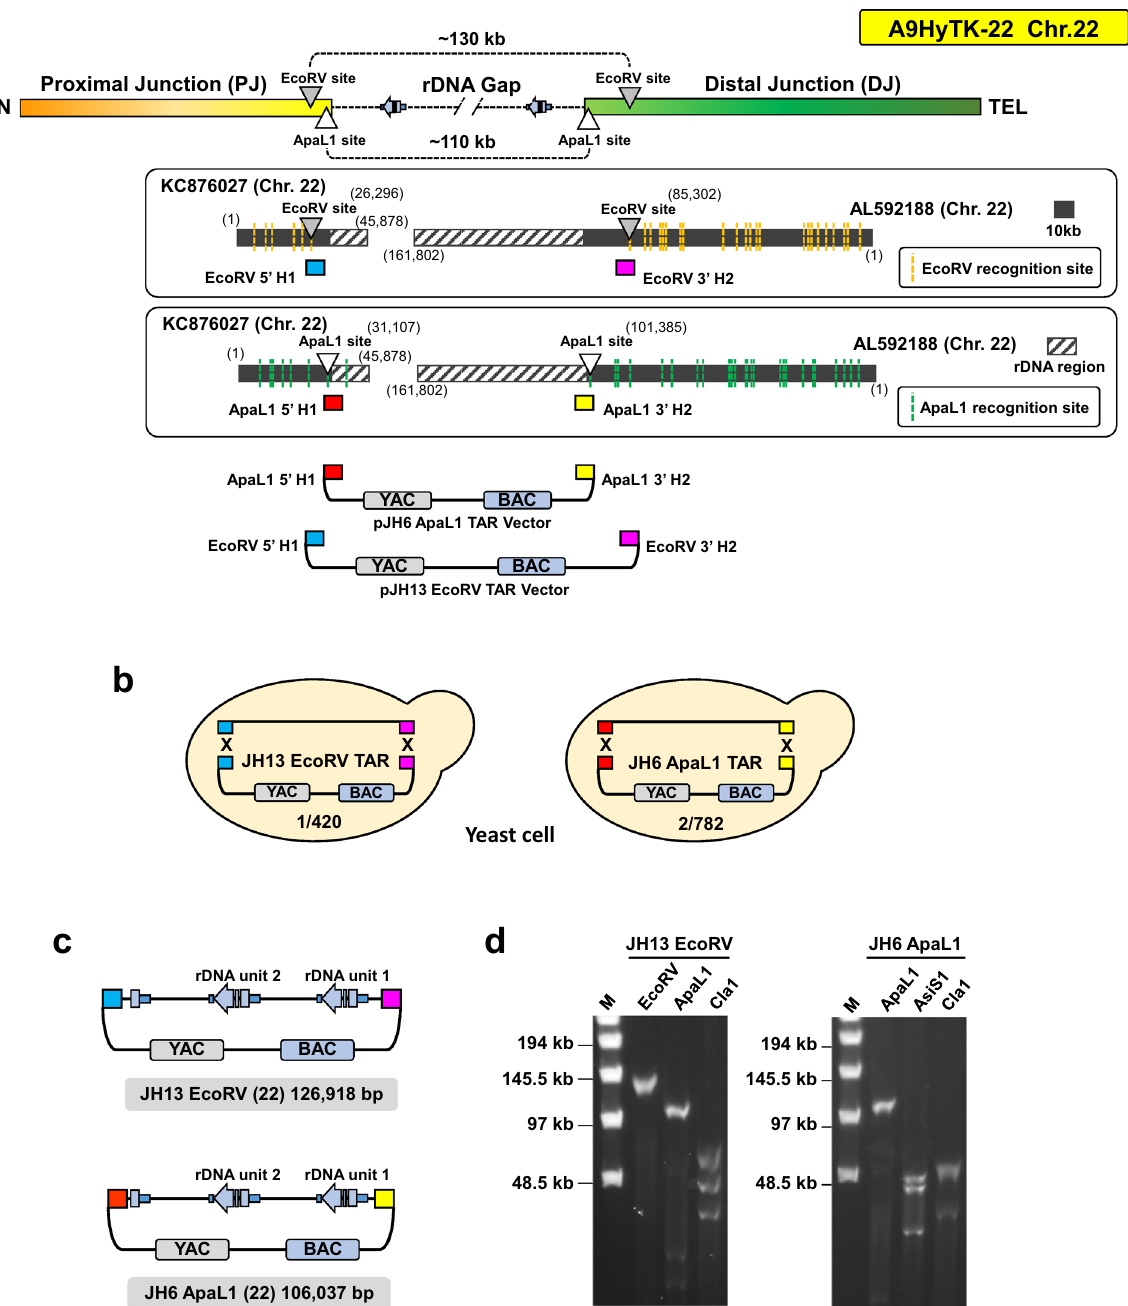
Figure 2. Designing of TAR cloning vector and Closing the rDNA gap on chromosome 22. ( A ) Schematic diagram illustrating the expected innermost EcoRV (gray triangle) or ApaL1 (white triangle) enzyme recognition sites of the human chromosome 22 rDNA gap region on A9HyTk-22 Mouse/Human monochromosomal hybrid cell line. The lower panels show EcoRV (yellow dotted lines) or ApaL1 (green dotted lines) recognition sites on human chromosome 22 proximal junction (PJ) cosmid (KC876027) and distal junction (DJ) BACs (AL592188). The rDNA repeats are indicated by black stripes pattern box. Two TAR vectors, pJH6 and pJH13, containing YAC and BAC cassettes and unique hooks were constructed. pJH6 vector contains ApaLI-5 ′ hook1 (in red) and ApaLI-3 ′ hook2 (in yellow). Vector pJH13 contains EcoRV-5 ′ hook1 (in blue) and EcoRV-3 ′ hook2 (in pink). EcoRV-5 ′ hook1 is located 6,249 bp upstream the rDNA cluster. EcoRV-3 ′ hook2 is located 16,278 bp downstream the rDNA cluster. ( B ) The diagrams show TAR cloning of the entire rDNA cluster on the chromosome 22 from total genomic DNA isolated from the A9HyTK-22 hybrid cell line and digested either by EcoRV or ApaLI with two linearized TAR vectors. Homologous recombination between the targeting sequences in the vectors and the targeted sequences on the chromosome 22 leads to the rescue of the rDNA cluster as circular TAR/YAC/BAC molecules, i.e. JH13 EcoRV and JH6 ApaLI. Using the pJH13 EcoRV vector, 1 out of 420 screened colonies were positive and the pJH6 ApaL1 vector was 2/782, respectively. ( C ) TAR isolates were transferred from yeast to E. coli cells for BAC DNA isolation and further sequencing. The length of the insert in the JH13/EcoRV-BAC is 126,918 bp. The length of the insert in the JH6/ApaLI-BAC is 106,037 bp. ( D ) The size of the rDNA cluster after BACs linearization by either EcoRV or ApaLI. M—a size marker [CHEF DNA Size Lambda Ladder (BIO-